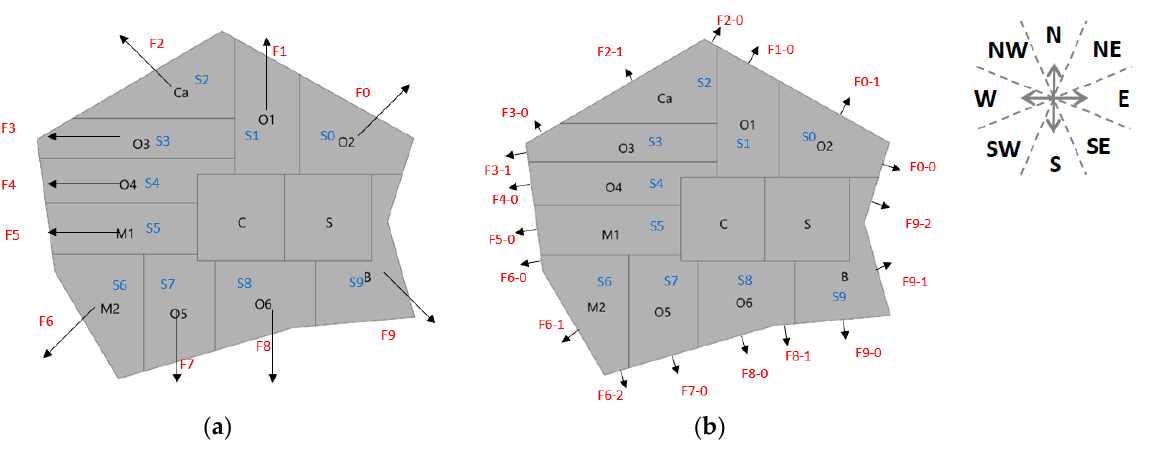
Figure 5. An example layout illustrating the calculation of design indicators. ( a ) Example layout and the orientation of each room defined based on internal walls, as black arrows show; ( b ) Example layout and the orientation of each façade shown with black arrows. Note: O1—office ‐ 1, O2—office ‐